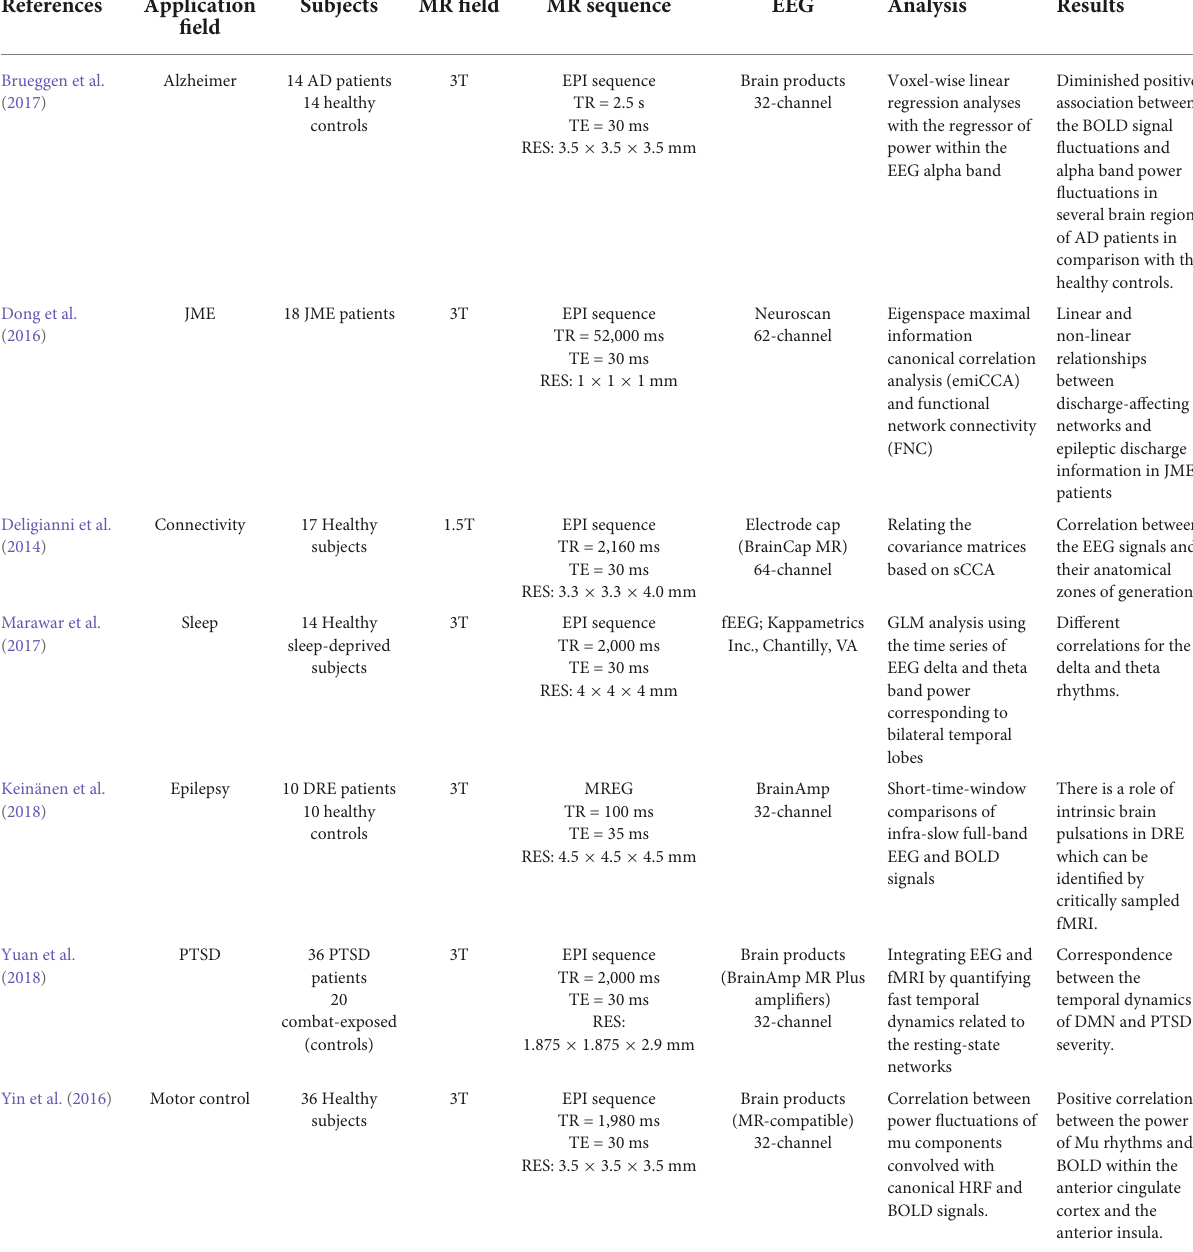
TABLE 1 A summary of the resting state EEG-fMRI studies since